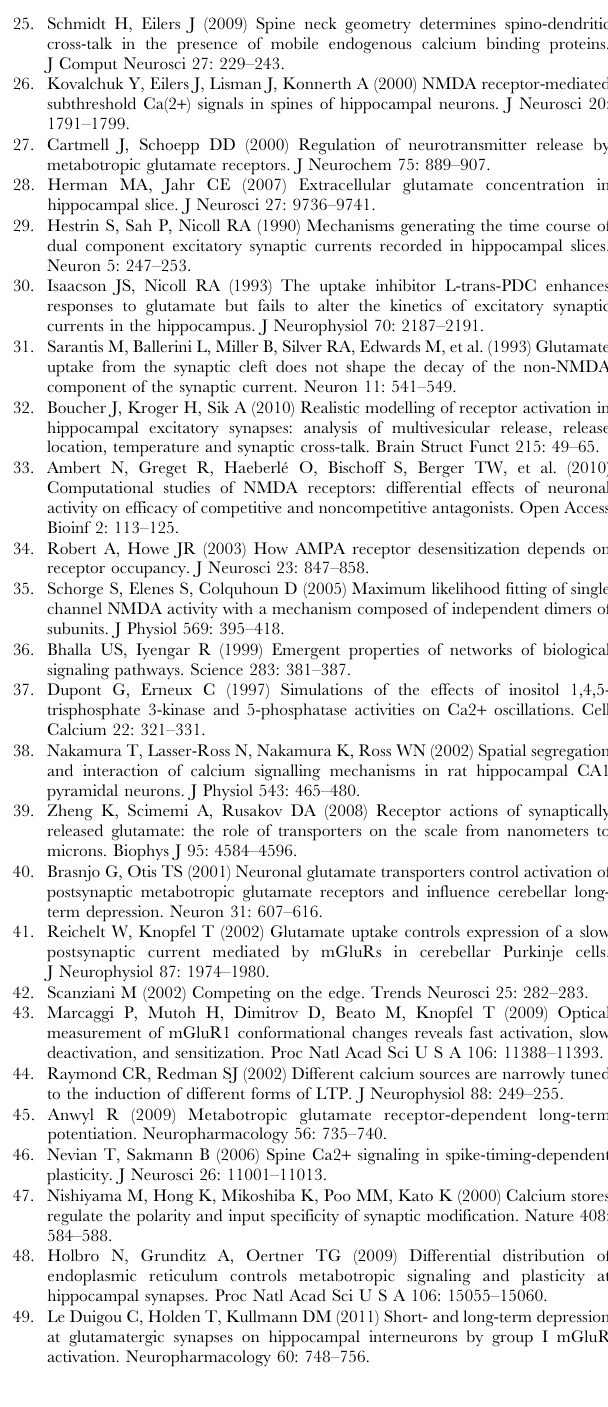
Table S1 Reaction equations, rate laws, and